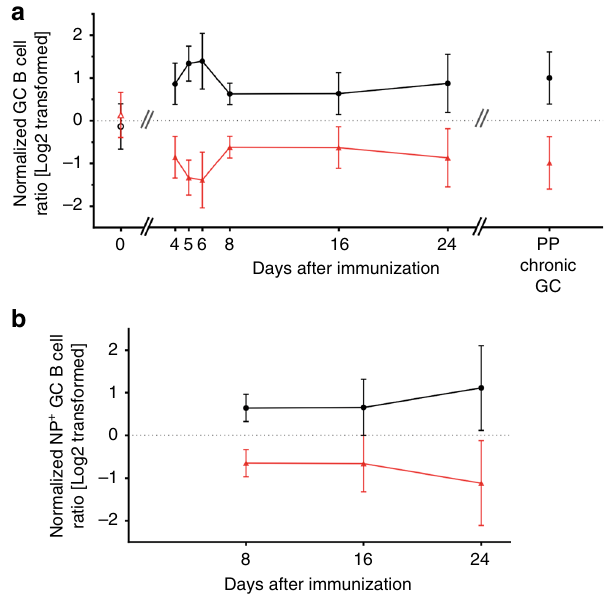
Fig. 4 MHCII haploinsuf fi cient GC B cells have robust competitive fi tness in GCs. Kinetics of the proportion of MHCII + / + cells and MHCII + / − cells within a total GC or b NP-binding GC B-cell compartments are shown. To normalize against B-cell chimerism variations in individual recipient animals, donor ratios in day 0 (unimmunized) splenic MF B cells were normalized to the donor ratios in BM LSK cells (MHCII + / + /MHCII + / − , black hollow circles; MHCII + / − /MHCII + / + , red hollow triangles). Donor ratios in the GC B cells (days 4 – 24 spleen and PPs) were normalized to the donor ratios in autologous MF B cells (MHCII + / + /MHCII + / − , black solid circles; MHCII + / − /MHCII + / + , red solid triangles). Data combined from three independent experiments ( n = 3 – 15 for each time point or group); bars indicate mean values (±S.D.) of each + + / + mice and half from CD45.1 MHCII WT mice. Equal numbers (5 × 10 6 ) of BM cells from both donors were transferred i.v. into